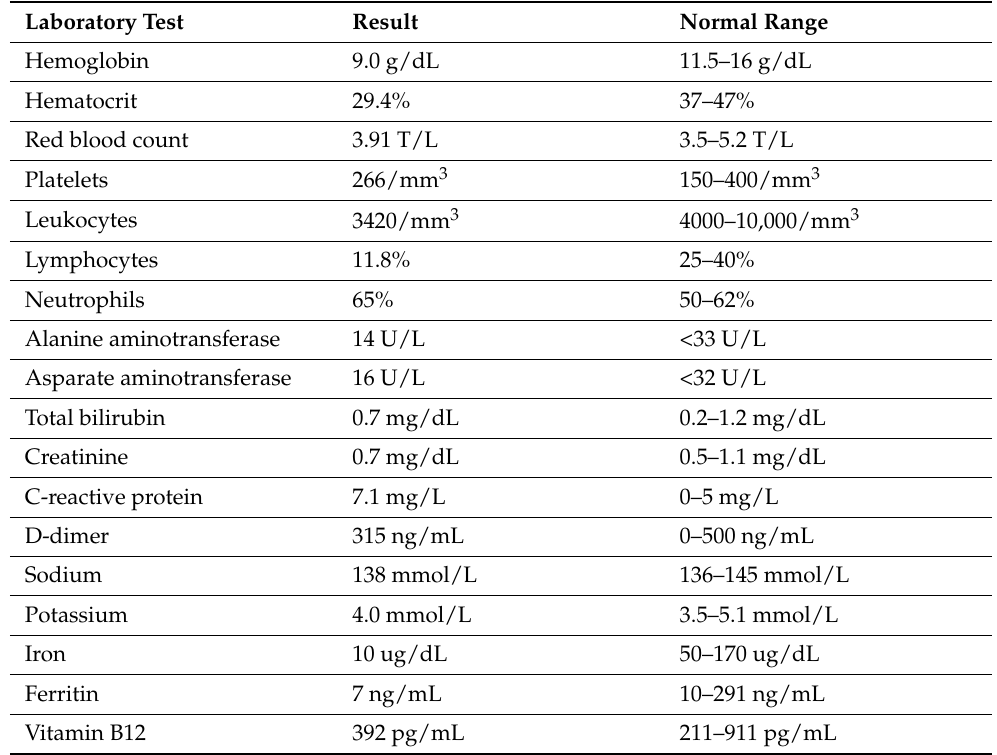
Table 2. Laboratory test results of the patient with HHT.